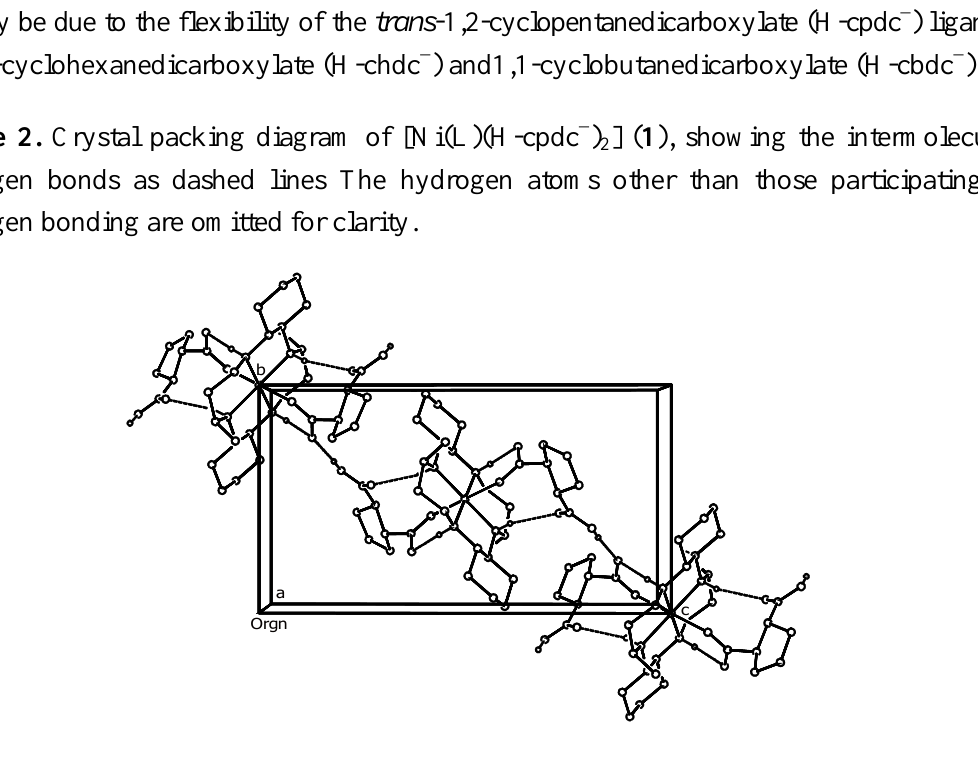
Table 2. Hydrogen bonding parameters (Å,  ) for [Ni(L)(H-cpdc  )